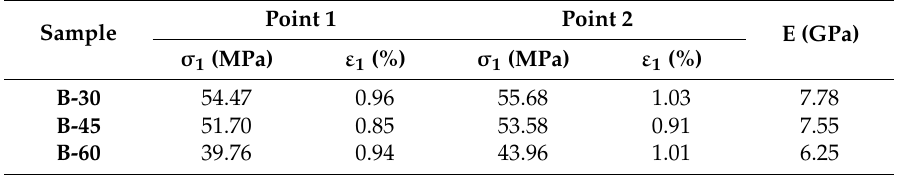
Table 1. The corresponding stress and strain values of the stress drop points (units: MPa; %;